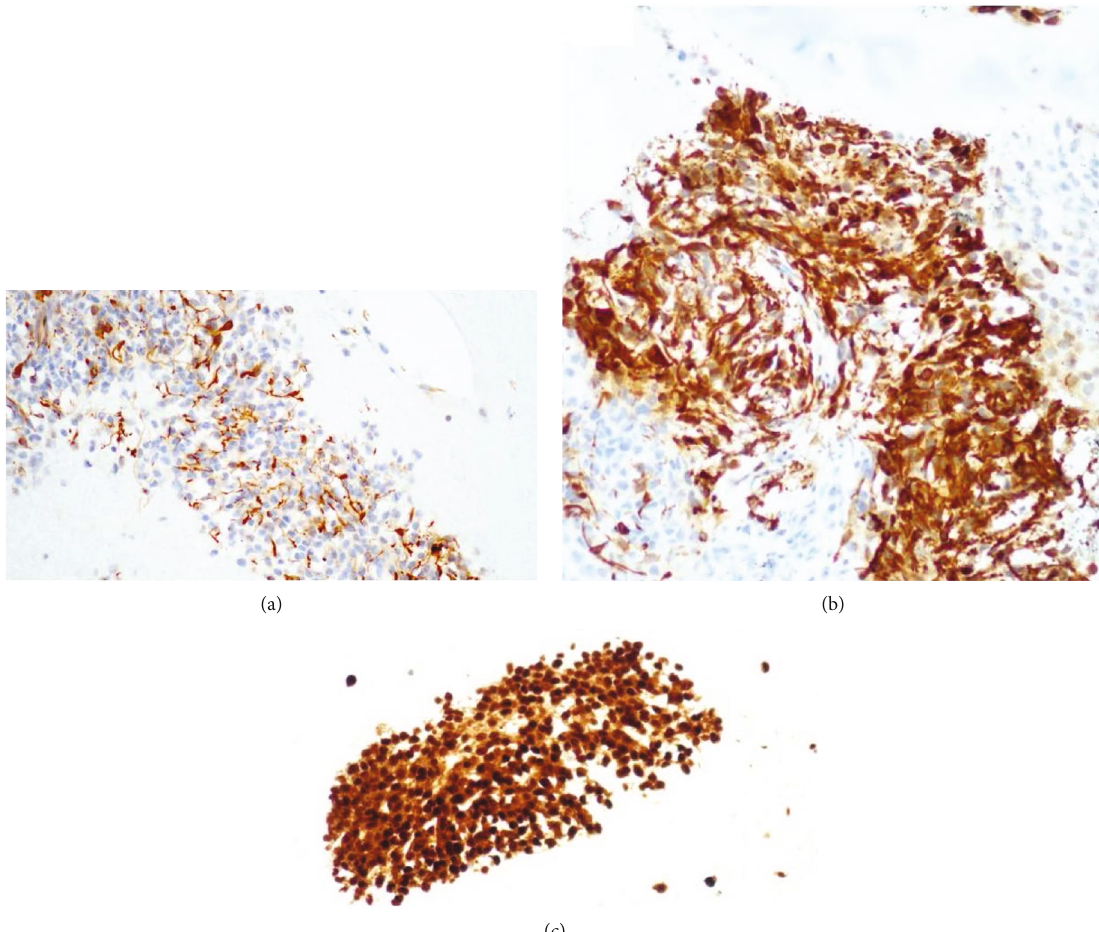
Figure 4: GFAP is immunoreactive in the tumor cells (a). (b) Strong positivity for synaptophysin. S100 protein immunostain demonstrates strong and di ff use positivity (c). Keratin is negative (not shown).